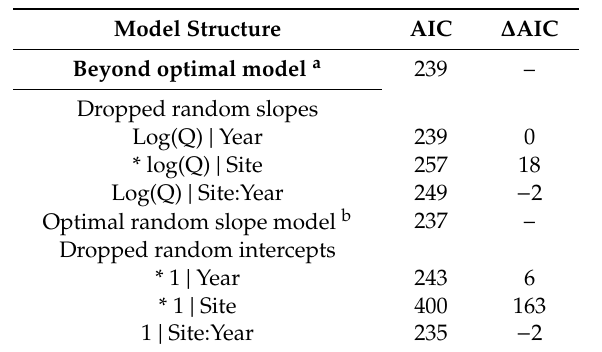
Table 3. Step-down model selection results for linear-mixed models predicting log[x]-transformed total dissolved solids within the Monongahela River. Asterisks denote random e ff ects retained in the final model (i.e., ∆ AIC >